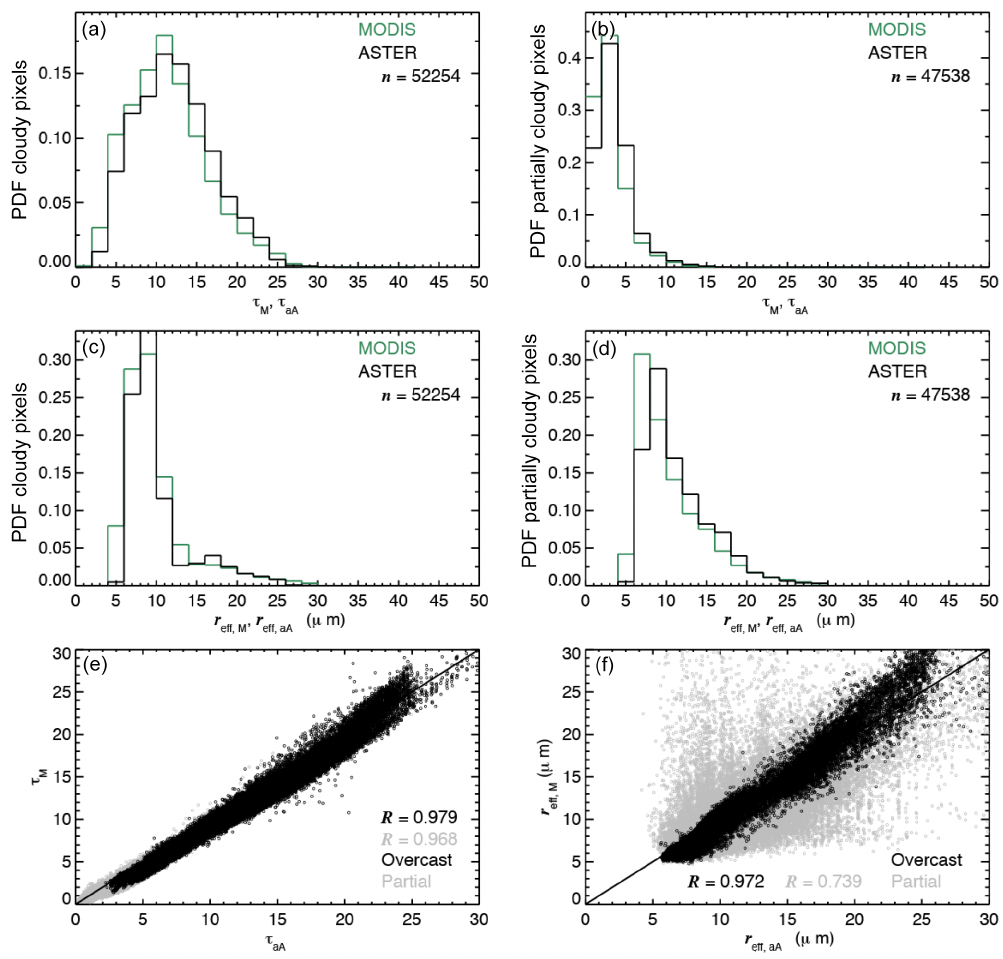
Figure 14. (a) PDFs of cloud optical thickness retrieved from MODIS reflectances ( τ M ) and co-located ASTER reflectances ( τ aA ). Only overcast pixels, containing both a successful MODIS and ASTER liquid water cloud retrieval, from the 48 MBL cases are considered in the calculation of the PDFs. The number of samples ( n ) is given. (b) Same as (a) but for partially cloudy pixels. (c) – (d) Same as (a) – (b) but for the effective droplet radius retrieved from MODIS reflectances ( r eff , M ) and co-located ASTER reflectances ( r eff , aA ). (e) Scatter plot of τ M and τ aA . Overcast (partially cloudy) pixels are indicated in black (gray) color. The diagonal line represents the 1 : 1 line. (f) Same as (e) but for r eff , M and r eff , aA